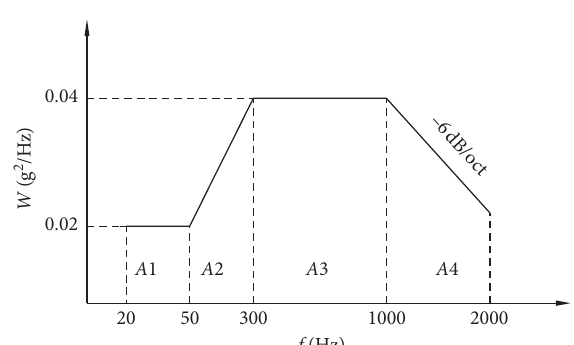
Figure 3: Functional test vibration spectrum.